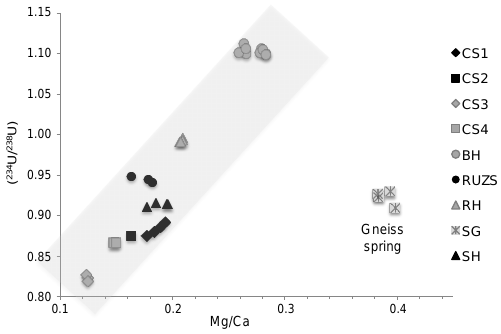
Figure 11. Variations of the ( 234 U / 238 U) AR vs. Mg / Ca ratio in the springs. The U AR are positively correlated with the Mg / Ca